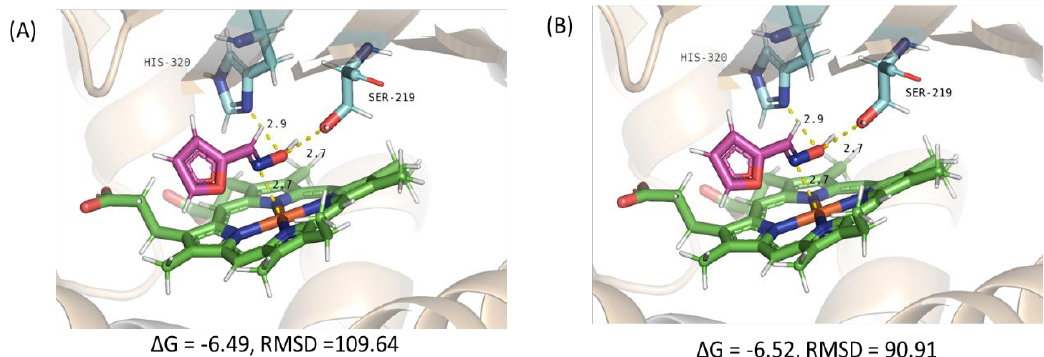
Figure 5. Binding pocket on OxdYH3-3 WT ( A ) and N266S ( B ) docking with E-2-furfuryl aldoxime. Only heme and residues His320 and Ser219, forming hydrogen bonds, are shown. Heme, E-2-furfuryl aldoxime, and the residues are shown as sticks colored in green, purple, and sky blue, respectively. The dashed lines showed distances between the atoms in a range of 2–3 Å .